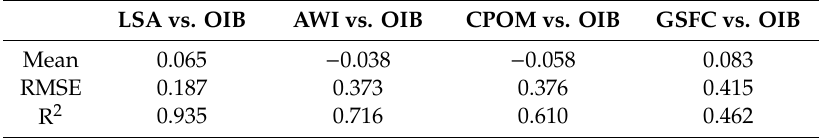
Figure 10. Scatterplot of the sea ice thicknesses from the LSA and the three sea ice thickness products versus those from the OIB, ( a ) LSA vs. OIB, ( b ) AWI vs. OIB, ( c ) CPOM vs. OIB, and ( d ) GSFC vs. OIB. Table 7. Statistics of the comparison between sea ice thickness from LSA as well as the three products and OIB.